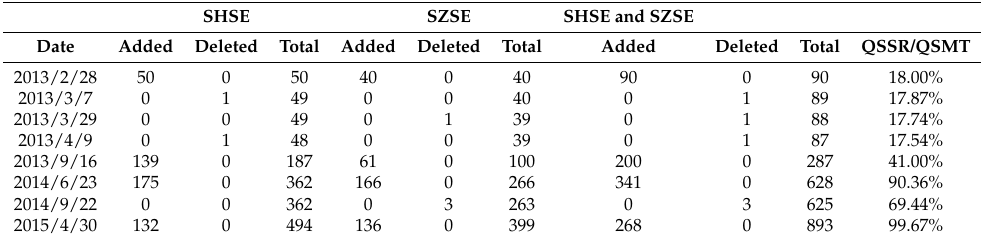
Table 2. History of adjustments to Qualified Securities for Short-sale Refinancing (QSSR) list. SHSE SZSE SHSE and